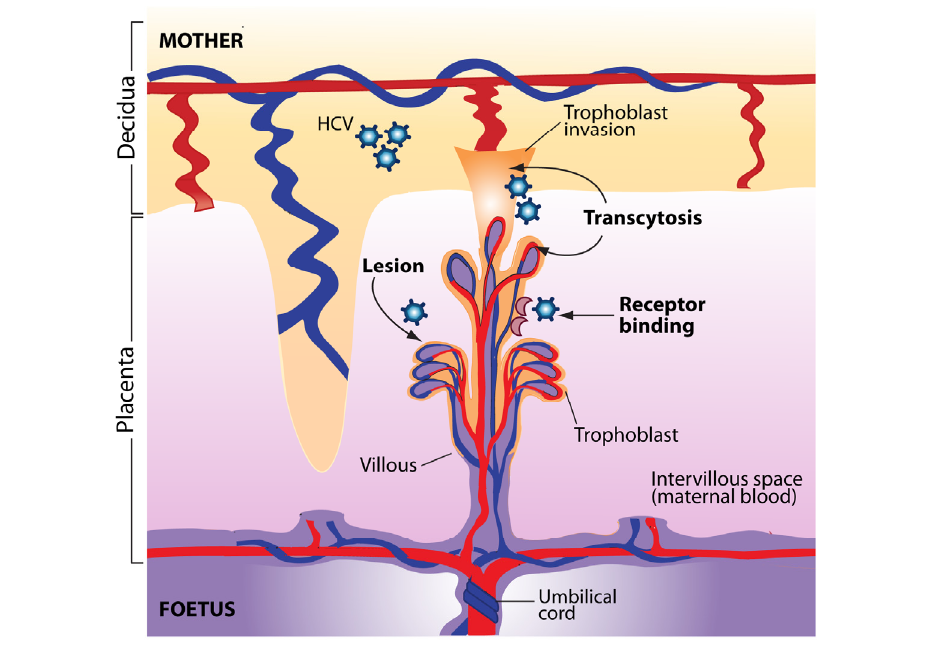
Figure 1. Potential pathways of hepatitis C virus (HCV) transmission to the foetus at the uterine-placental interface. The structural units of the placenta are the chorionic villi that float in maternal blood (intervillous space). Villi are composed of a stromal core with blood vessels, surrounded by cytotrophoblast progenitor cells. As a part of their differentiation program, extravillous cytotrophoblasts join a column at the tips of the anchoring villi and invade the uterine wall. Syncytiotrophoblasts that cover floating villi mediate exchanges of substances and passive transfer of IgG from maternal blood to the foetus. HCV transmission to the foetus could occur through viral transcytosis across trophoblast cells, could be mediated by HCV receptors expressed at the surface of placental cells, or could result from direct or indirect injury that compromise the integrity of the placental